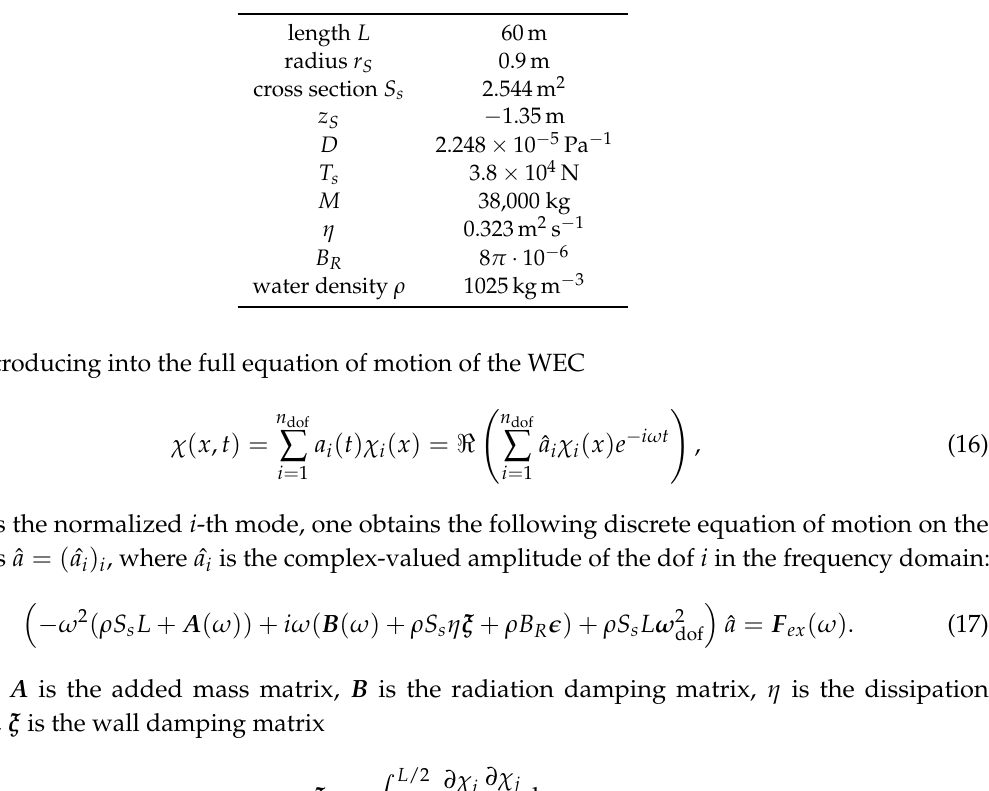
Table 1. Parameters used for the model of the